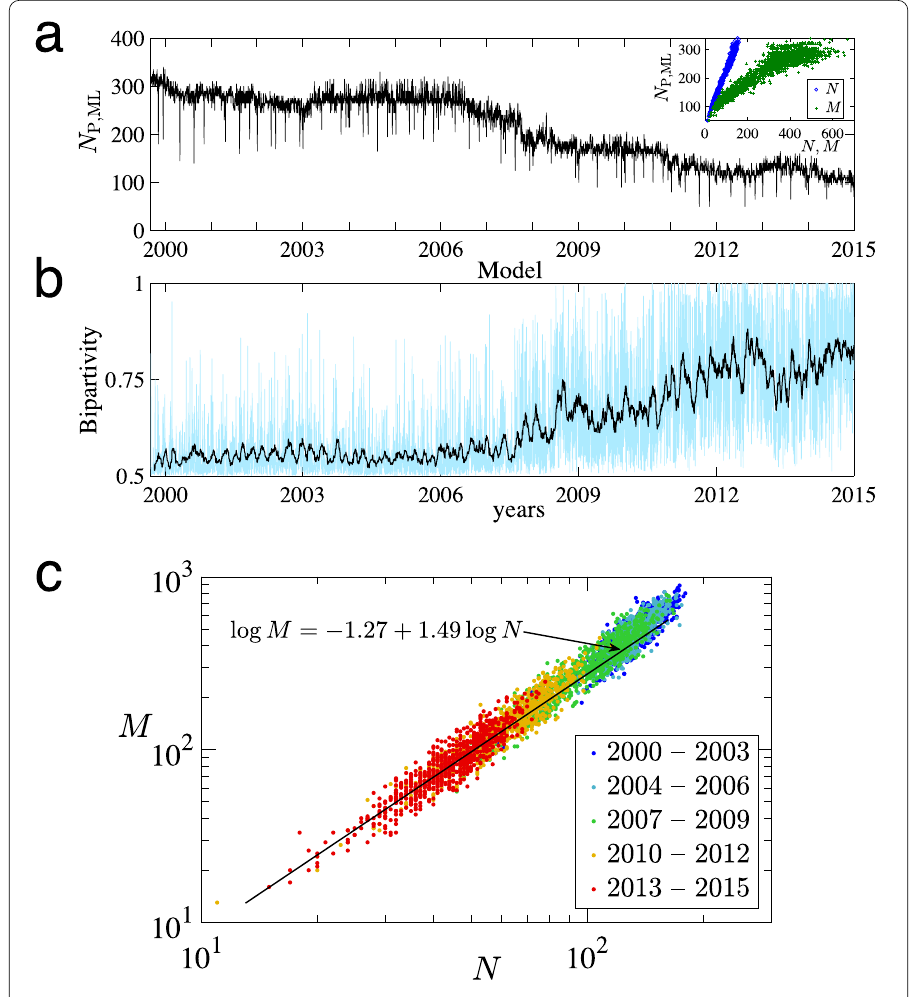
Figure 6 Dynamic characteristics of fitted daily networks. ( a ) Time series of N P , ML . Inset : Scatter plot of N P , ML against empirical N and M . ( b ) Bipartivity of fitted daily networks. Black line represents the moving average with 20-day smoothing window. ( c ) Scatter plot of N and M of fitted daily networks. A dot corresponds to a day. Solid line illustrates the empirical regression line identical to that shown in Fig. 2(a)